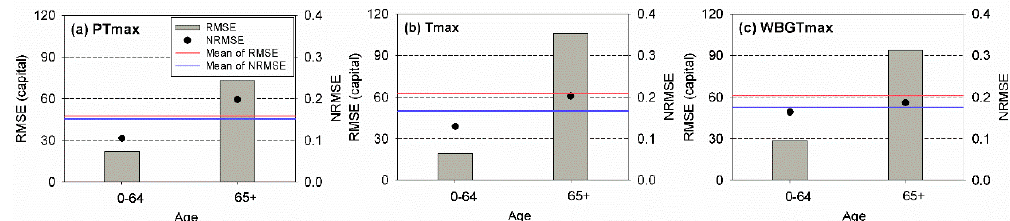
Figure 7. Root-mean-square error (RMSE) and normalized RMSE of the observed and estimated annual total mortalities for ( a ) PTmax, ( b ) Tmax, and ( c ) WBGTmax for young (0–64) and elderly (64+) people for the training period (2000–2016).